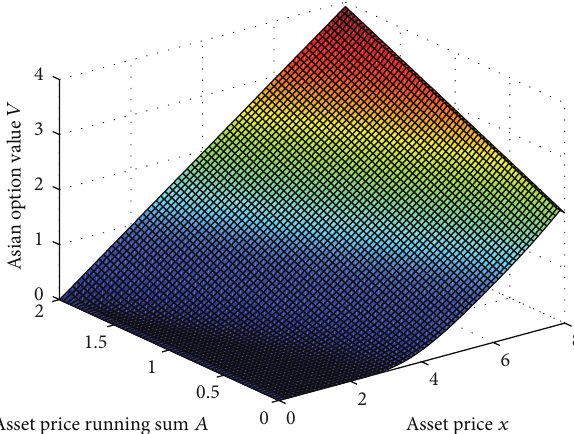
Figure 1: Computed Asian option value 𝑉 for Test 1.